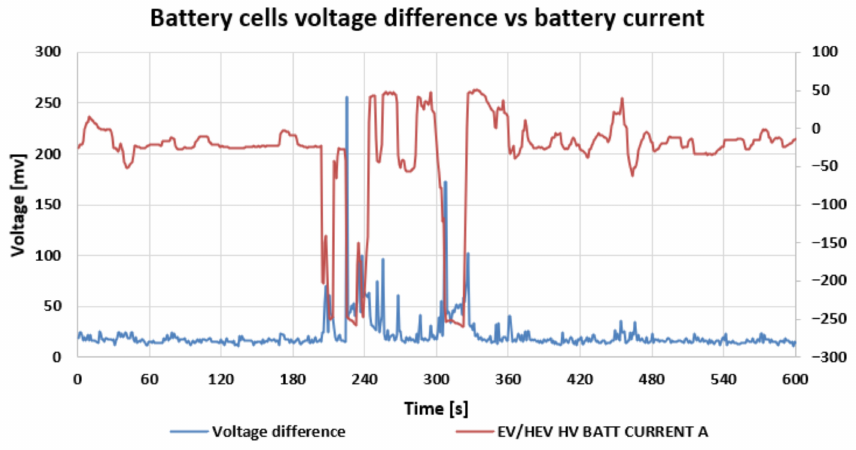
Figure 6. Voltage deviation and load current during measurement. Table 3. Percentage distribution of the lowest-voltage cells, based on the serial